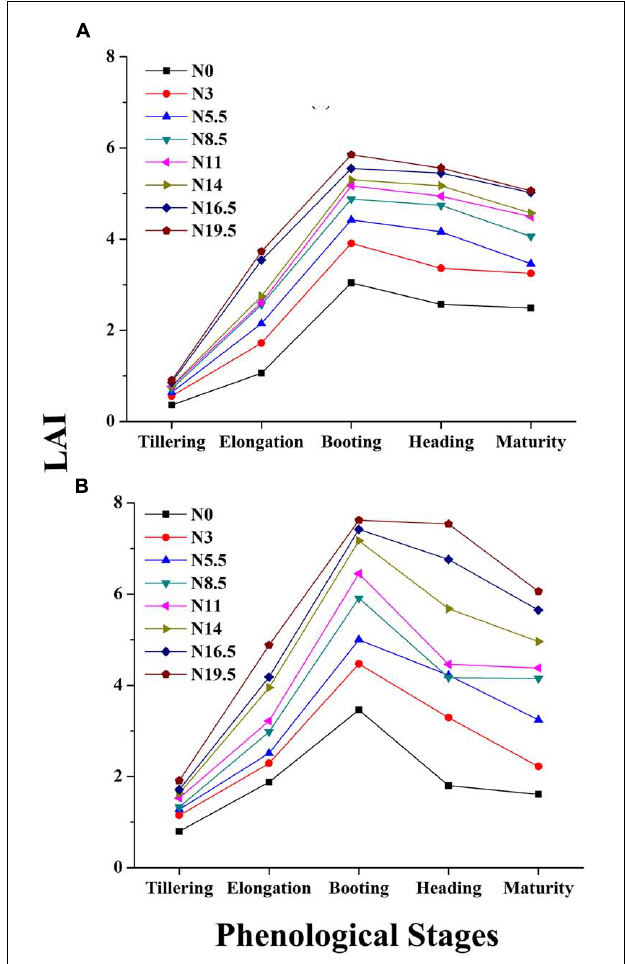
FIGURE 5 | Changes in LAI over the phenological period from tillering to maturity of rice under different N rates in 2015 (A) and 2016 (B) , where N0, N3, N5.5, N8.5, N11, N14, N16.5 and N19.5 represents 0, 45, 83, 128, 165, 210, 248, and 293 kg N ha − 1 respectively.